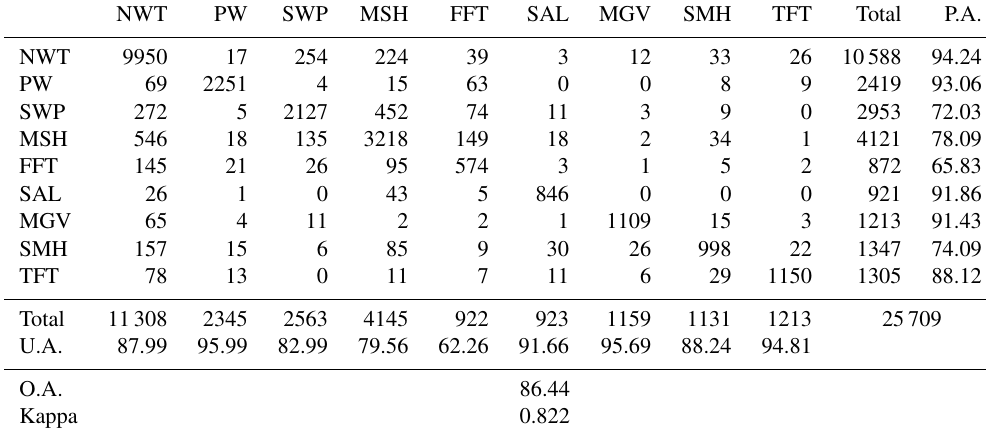
Table 5. The confusion matrix of the global 30m fine wetland map using 25709 validation